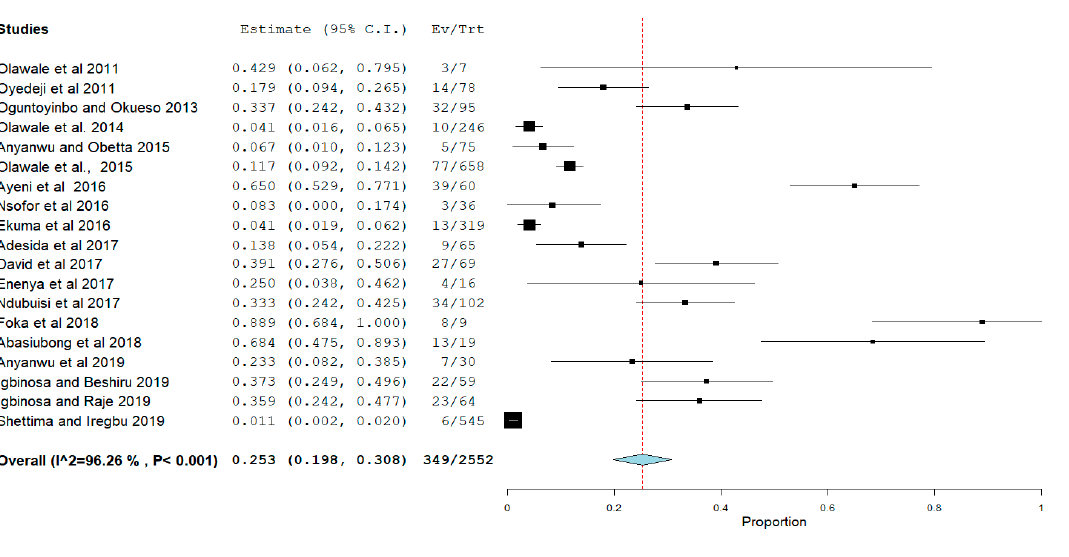
Figure 4. Leave-one-out forest plot of VRE in Nigeria.